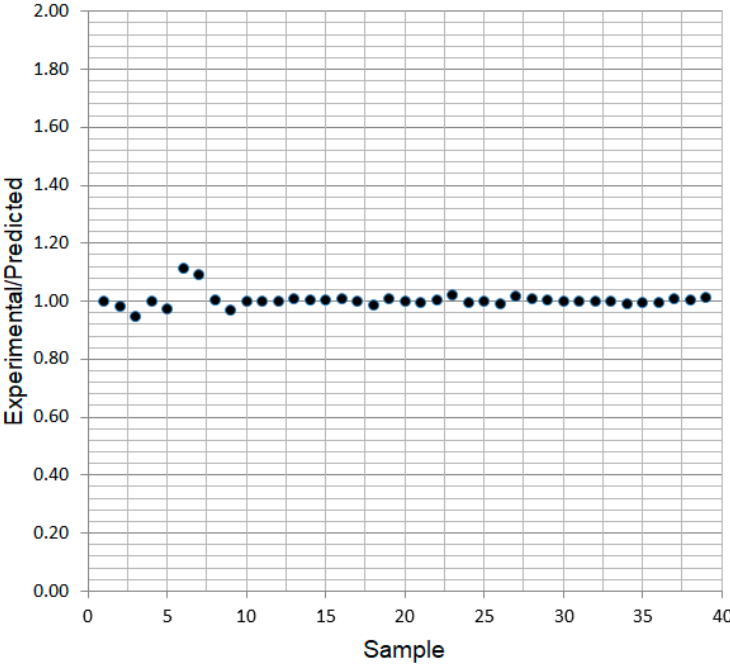
Figure 19. Experimental versus predicted values of convergence for validation datasets.